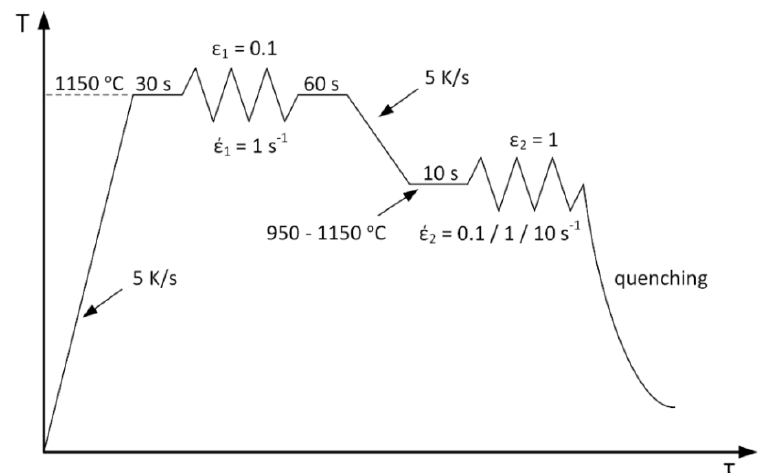
Figure 1. Scheme of the compression test.